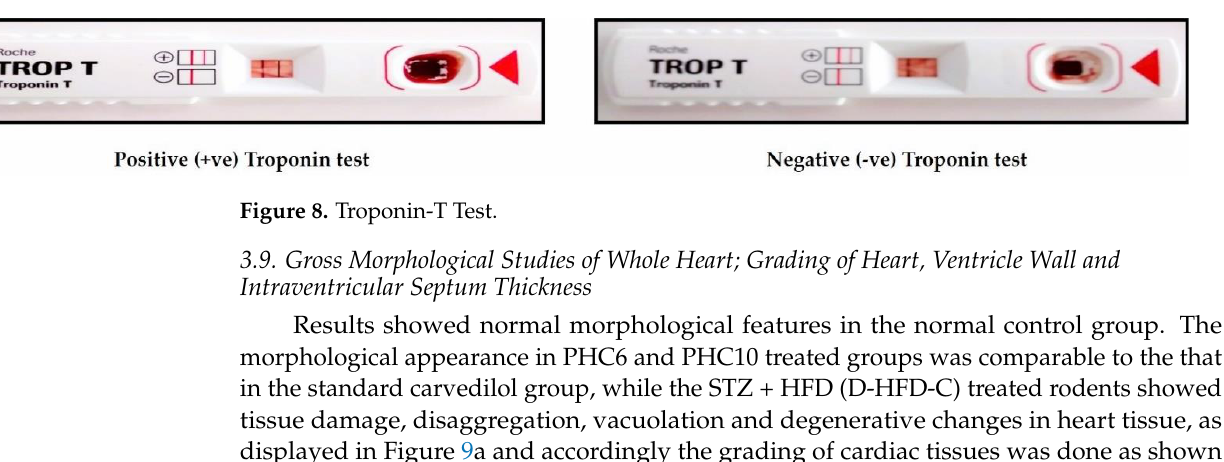
14 Figure 7. Western Blot α/β Myosin Heavy Chain (MHC) expression . All values are expressed as Mean ± SD (n = 6). The values were analysed bt one way ANOVA & followed by Tukey’s t -test and were found to be significantly different at (a,b) p < 0.05 when D-HFD-C was compared with NC & all other Treatment groups were compared with D-HFD-C. Where, NC is normal control; D-HFD- C is Diabetic High Fat Diet Control; PHC-6 & PHC-10 are polyherbal combination treated groups. 3.8. Troponin-T Test The blood from different groups (0.1 mL – 0.5 mL) was put in the well of test pack and left undisturbed for 20 – 30 min, reference images of test results attached as Figure 8. The appearance of two lines on the kit plate showed positive results and indicated the pres- ence of Troponin in the blood sample, whereas negative results were reflected as a single line only, as shown in Table 4 below. Table 4. Effect of olive oil based polyherbal combination pretreatment on Troponin-T in STZ in- duced diabetic cardiomyopathy.